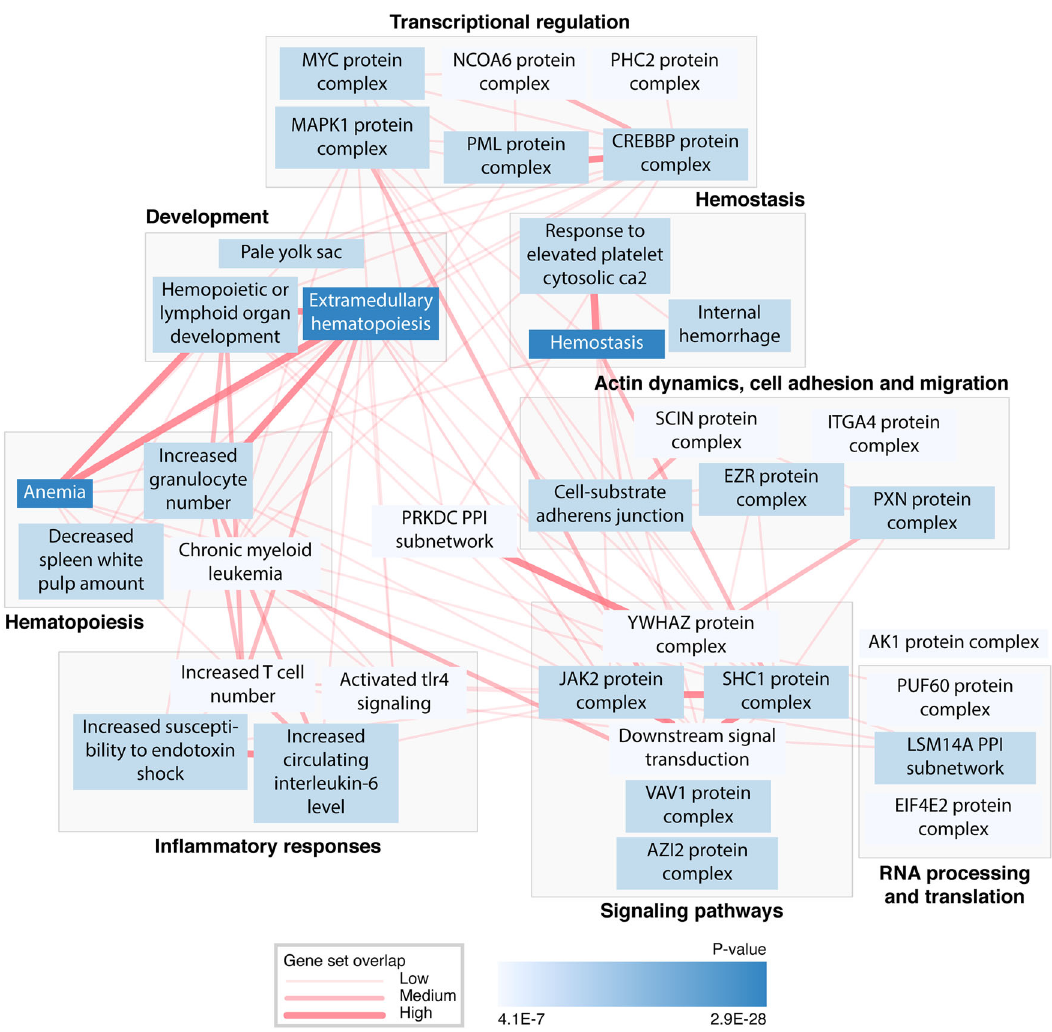
Fig. 2 A network of gene sets identi fi ed in the DEPICT analyses. Gene sets from the gene set enrichment analysis were clustered according to their most relevant biological functions. Only the topmost gene sets of the clusters with eight or more signi fi cant gene sets are presented (signi fi cance criteria: P value ≤ 3.46 × 10 − 6 ). Connecting lines represent gene set overlap if Pearson correlation > 0.3, with thicker lines indicating higher correlation. For detailed information on gene sets, clusters, and Pearson correlation between the sets, see Supplementary Data 13 and